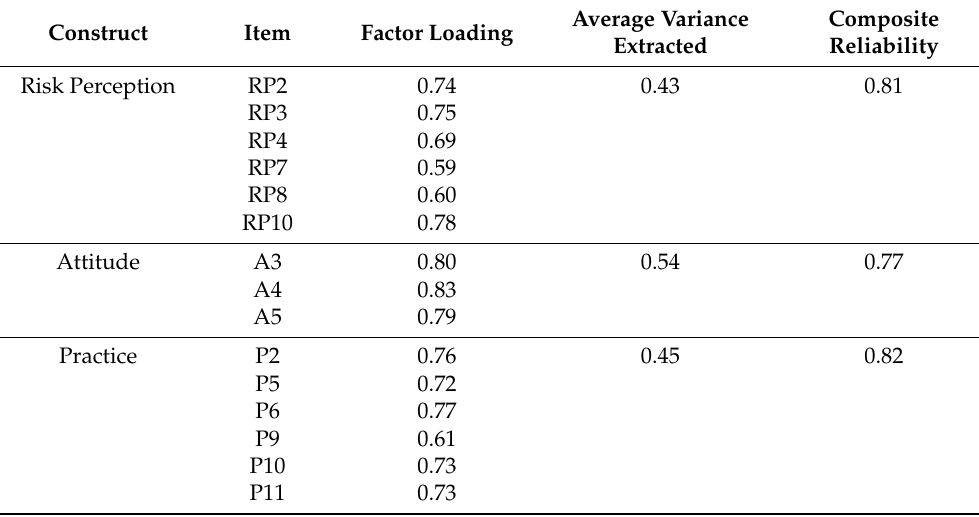
Figure 1. CFA of the risk perception, attitude and practice model. Table 5. Factor loading of each item with their respective construct and the convergent validity, composite reliability